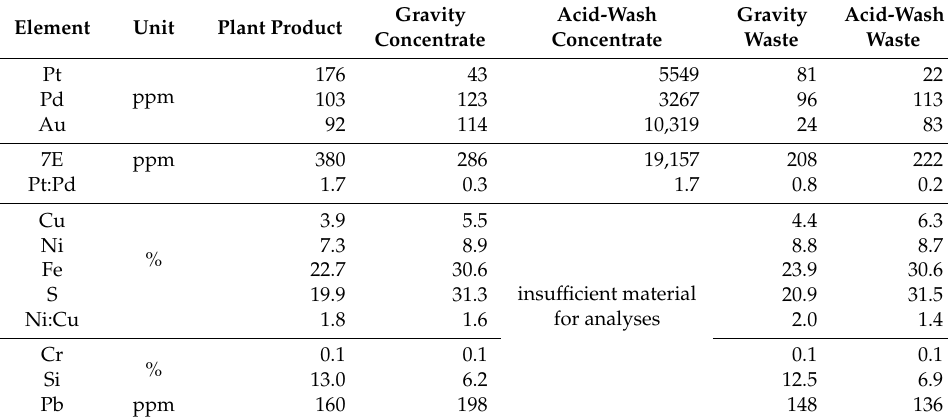
Table 3. Chemical compositions of a Platreef plant product (high sulphide content). Element Unit Plant